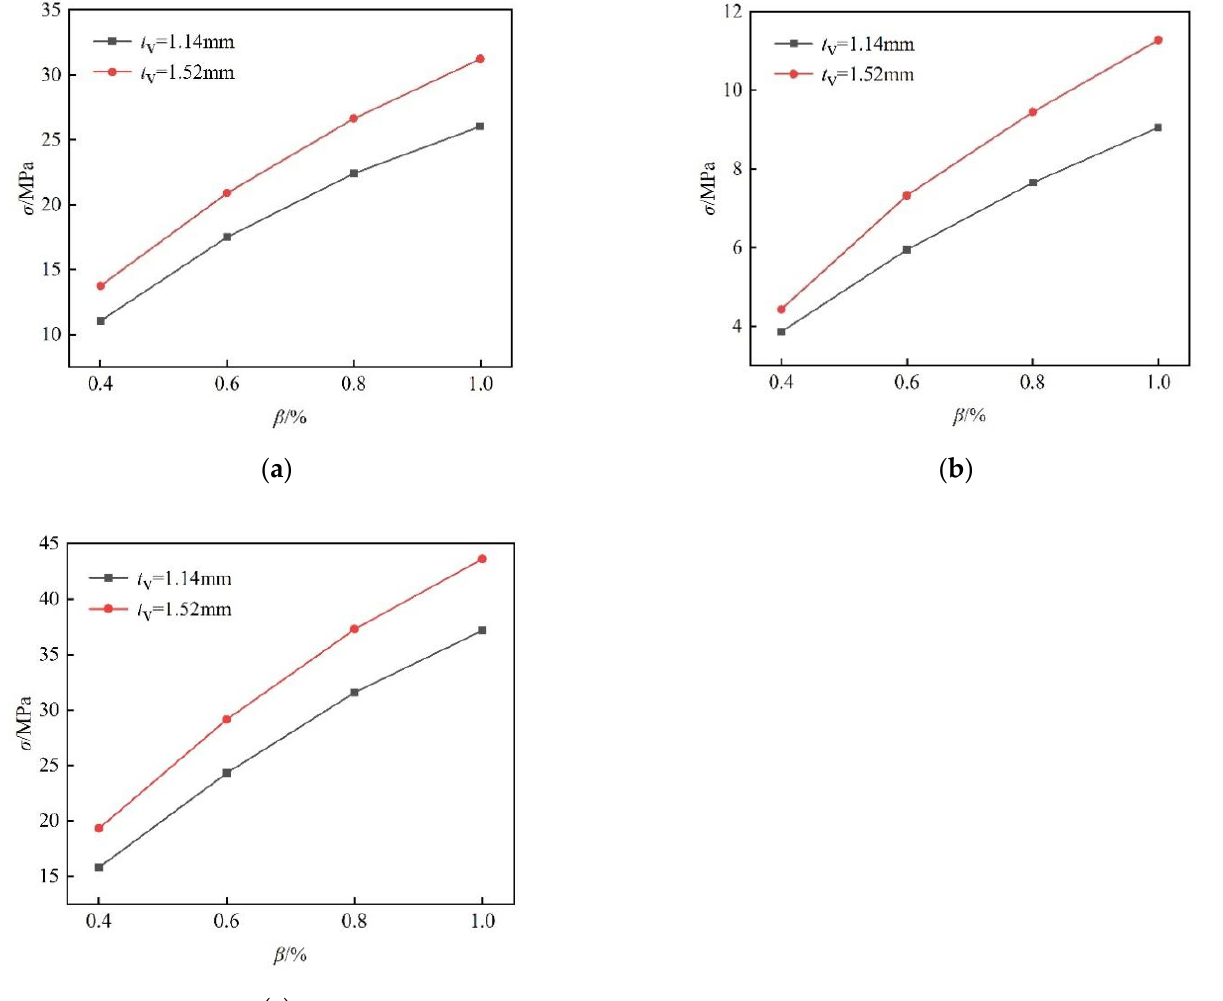
Figure 6. The cold-bending stress versus cold-bending curvature curves. ( a ) Testing point S14; ( b ) Testing point S22; ( c ) Testing point S30.